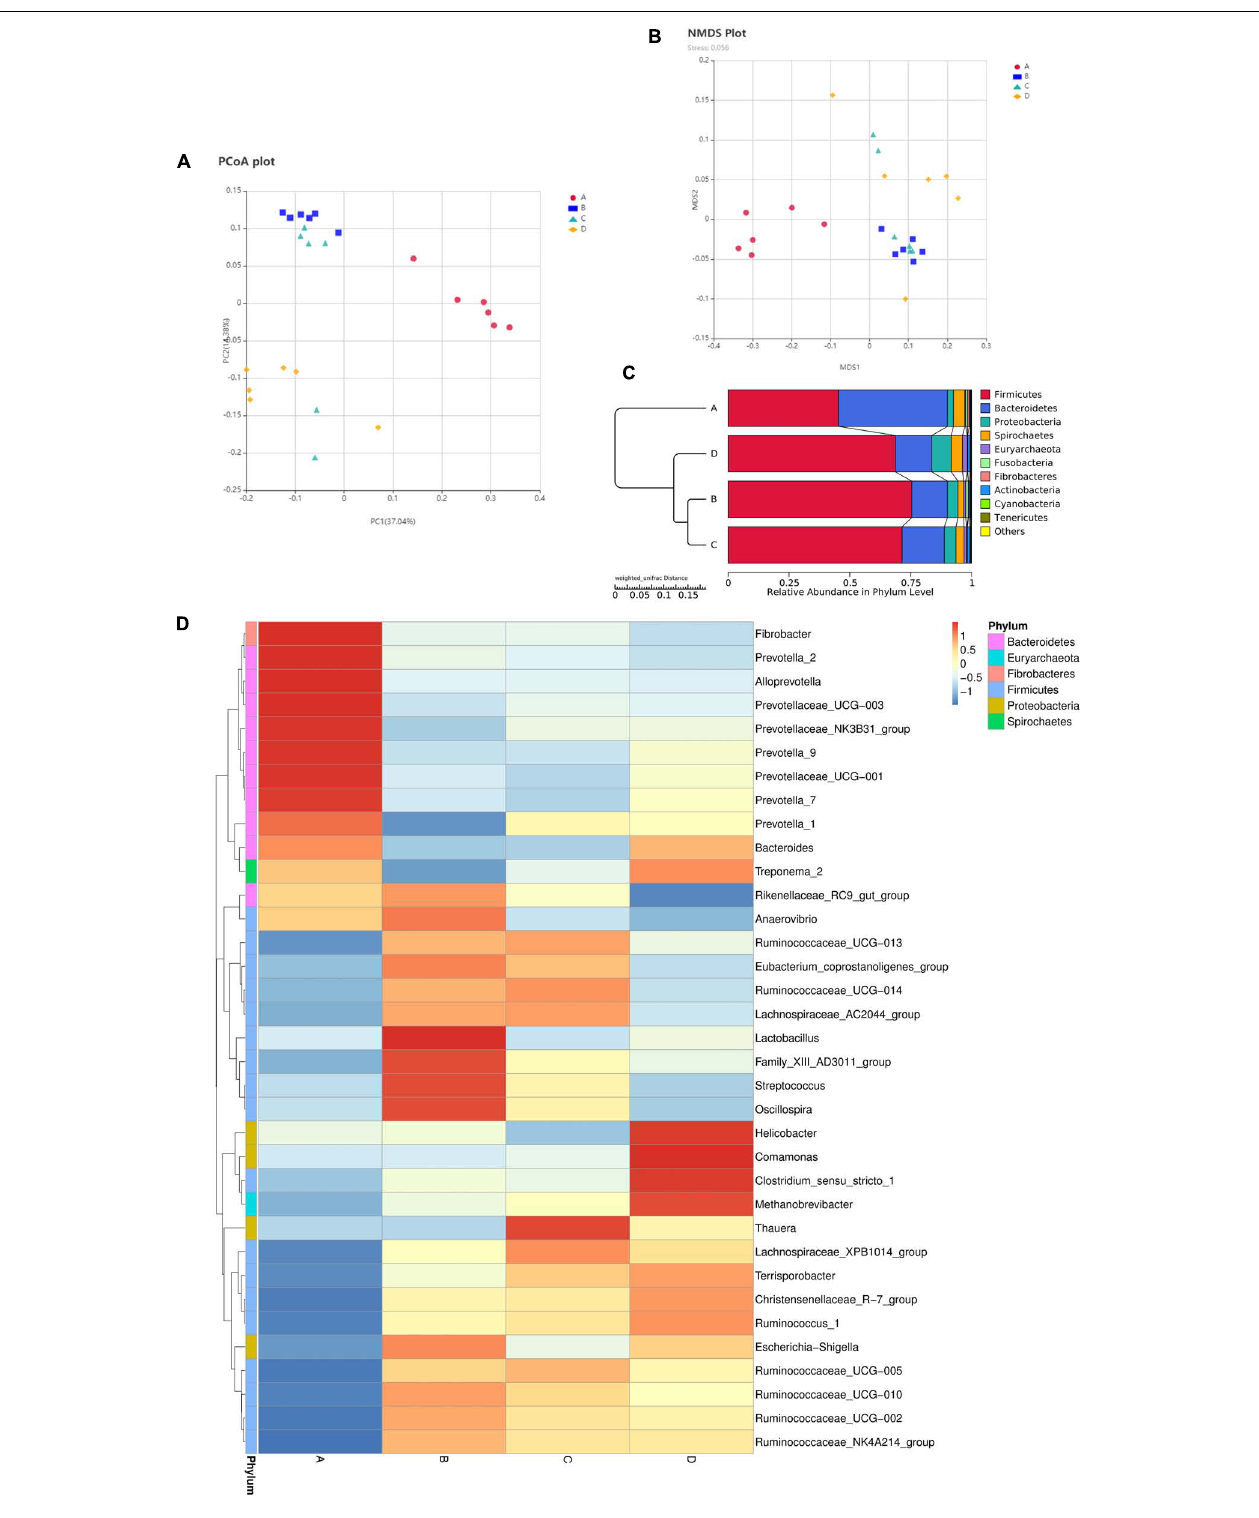
FIGURE 2 | Composition differences of gut microbiota in sows. (A,B) Principal coordinate analysis (PCoA) and non-metric multidimensional scaling (NMDS) analyses. (C) Unweighted pair-group method with arithmetic mean (UPGMA) analysis. (D) Heatmap showing significantly different genera among groups. n = 6. A,C: sows with high productive capacity (HPC) at late pregnancy (LP) and early stage after parturition (EAP) separately; B,D: sows with low productive capacity (LPC) at late pregnancy (LP) and early stage after parturition (EAP) separately.